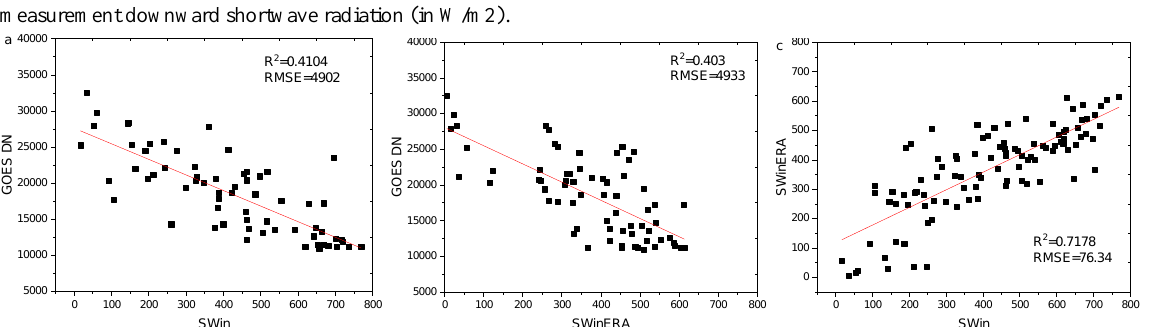
Figure.3. Comparison of satellite based DN values with in-situ measurement Shortwave radiation input in 15:00. GOES DN is the GOES-13 visible band’s record. SWinERA is the ERA reanalysis downward shortwave radiation and SWin is the flux tower in-situ measurement downward shortwave radiation (in